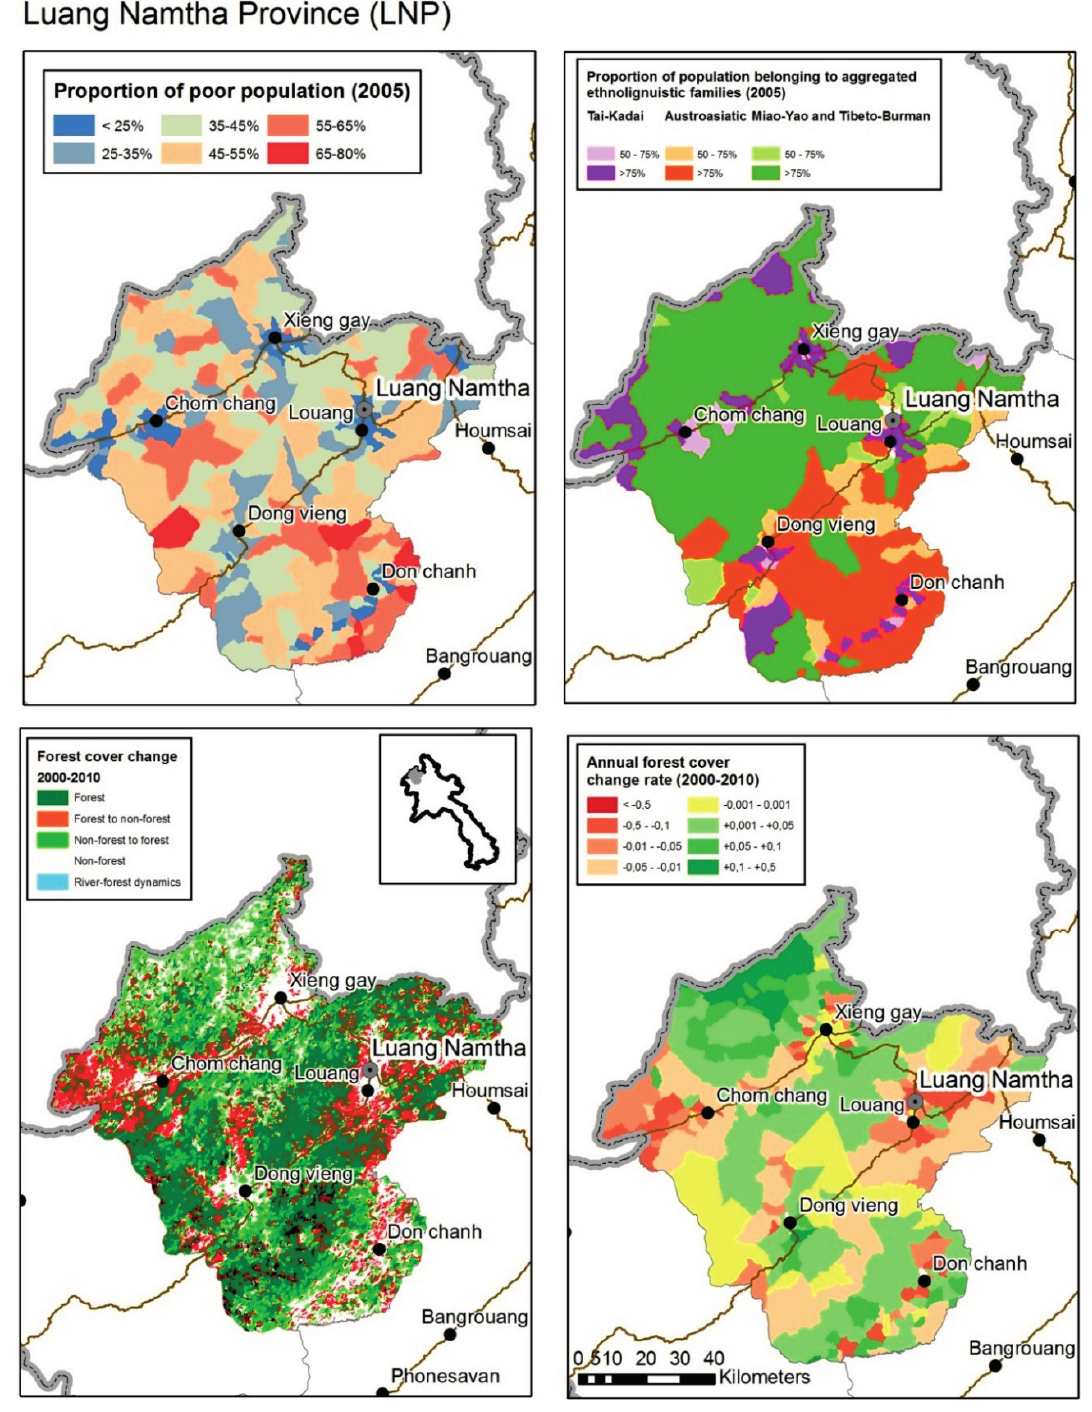
Figure 9. Poverty, ethnic groups and forest cover change in the Luang Prabang